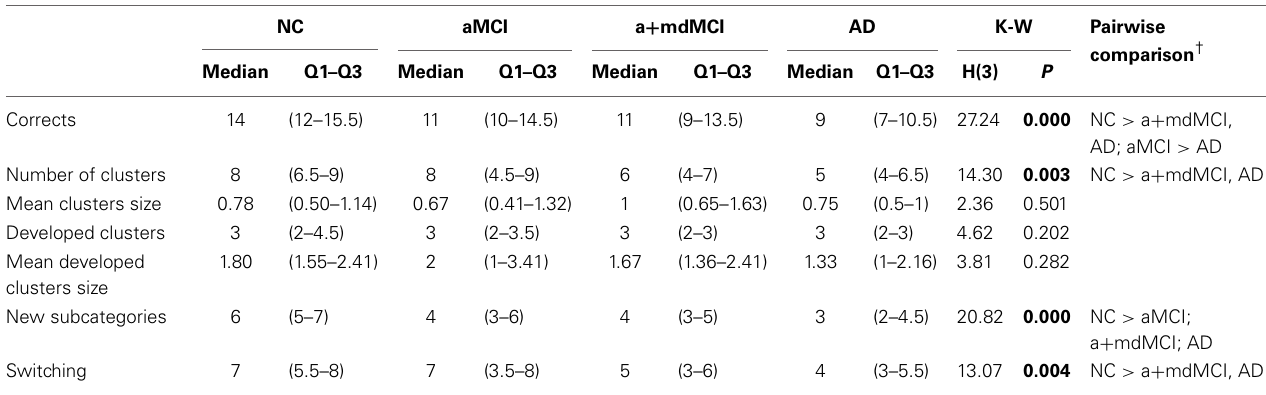
Table 4 | Verbal fluency measures description of NC, aMCI, a-mdMCI, and AD groups.